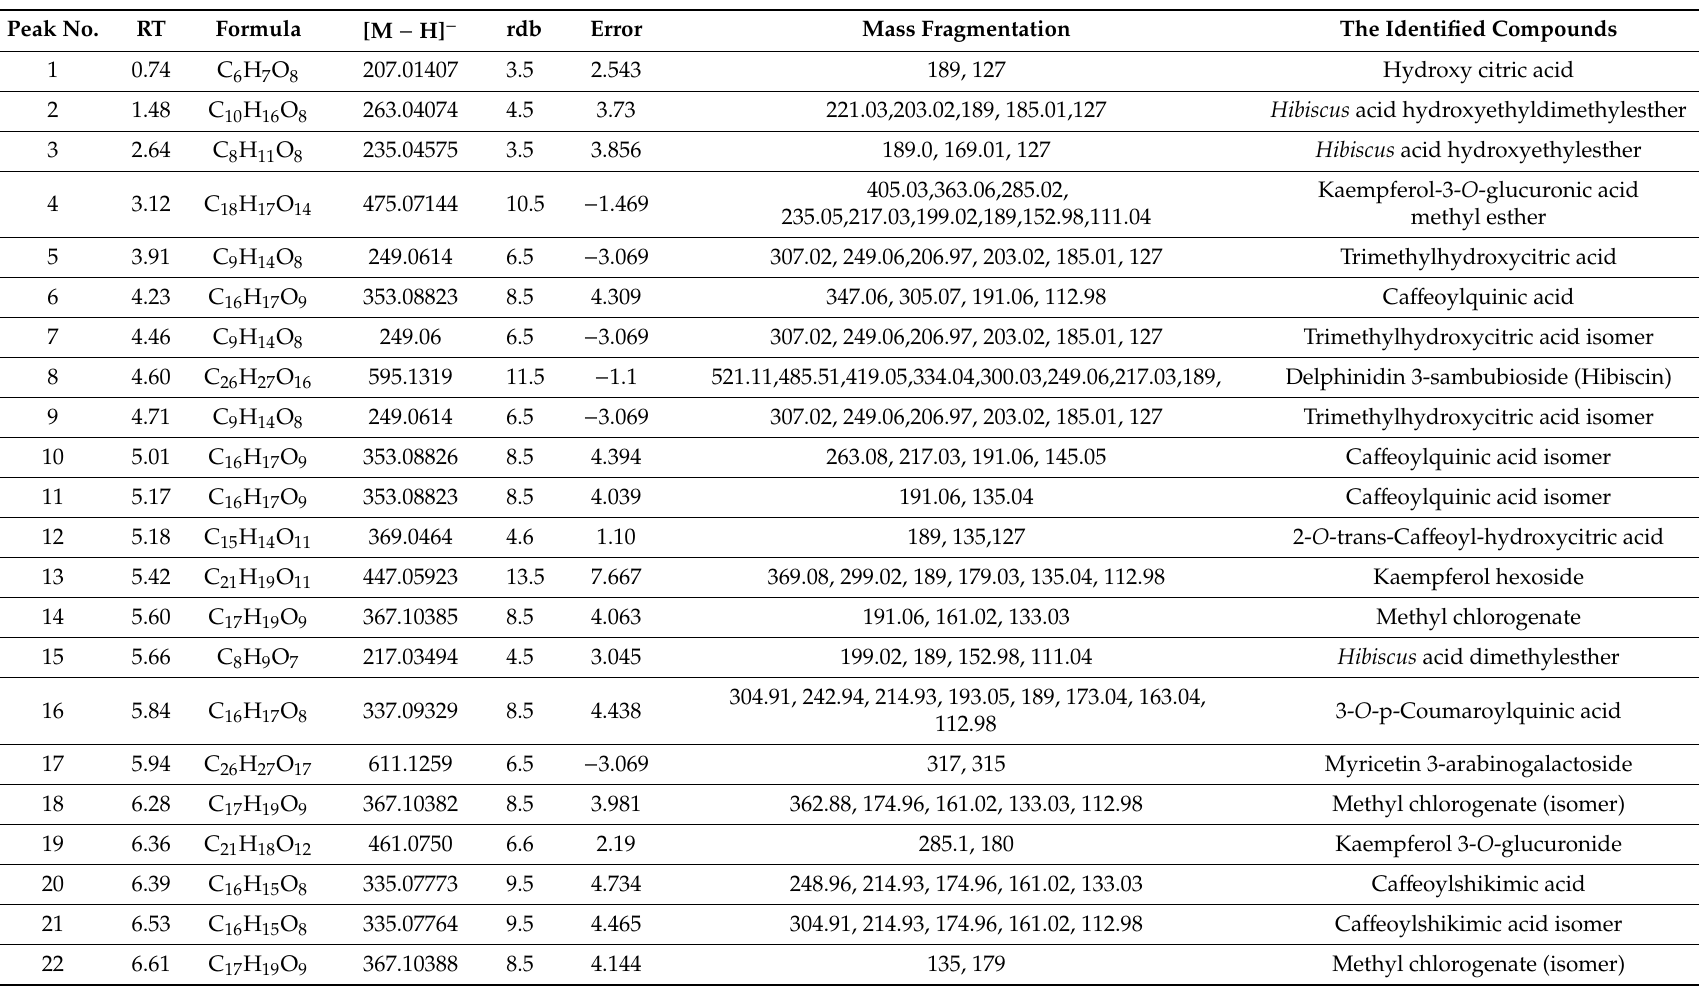
Table 2. Peak assignments of metabolites using ultra-performance liquid chromatography (UPLC)-MS / MS in the negative mode. Peak